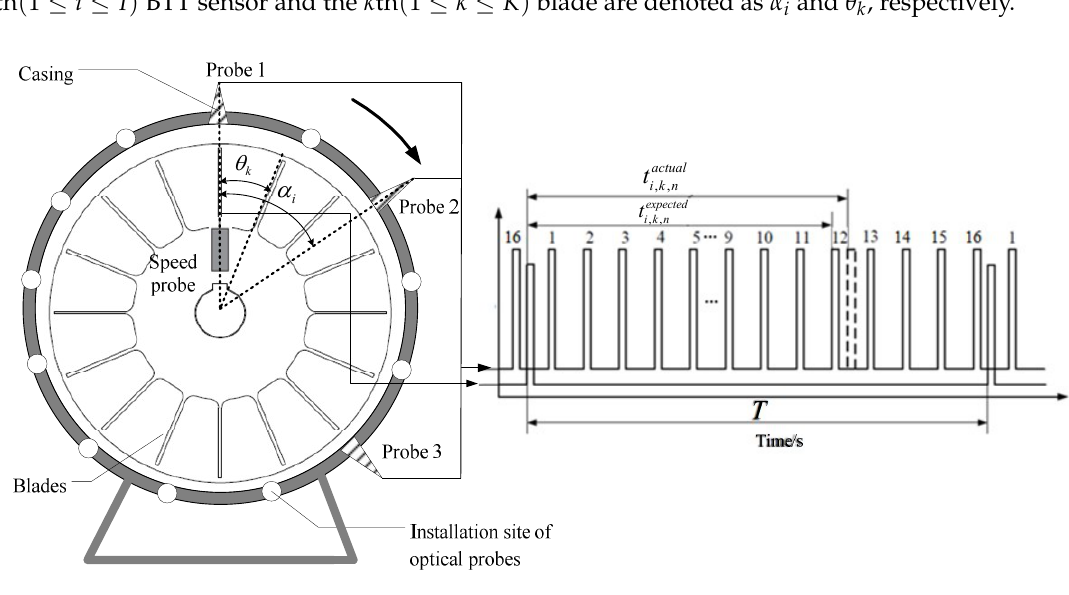
Figure 1. Basic principle of the blade tip-timing (BTT) method.